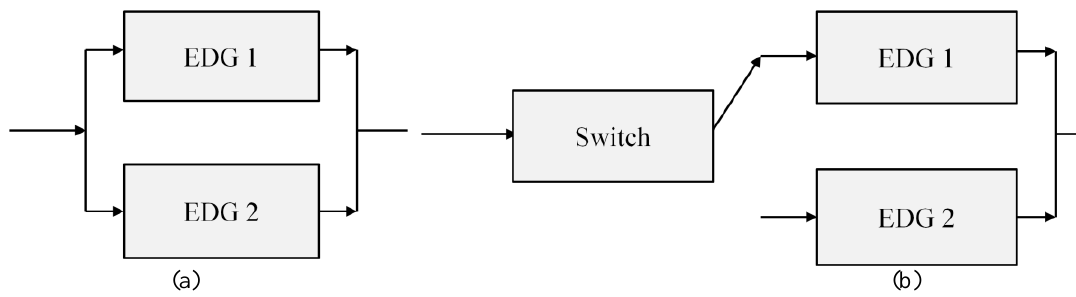
Figure 3. RBD for two EDGs in configurations of (a) “active redundancy” and (b) “standby redundancy” - based on Li